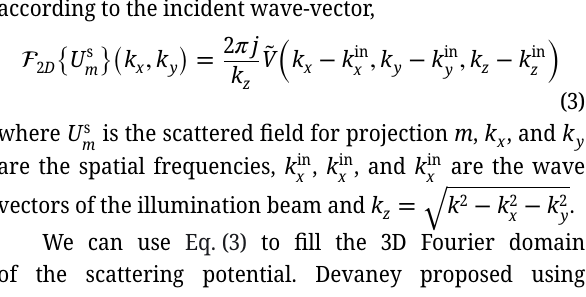
= 1.516 based on 0